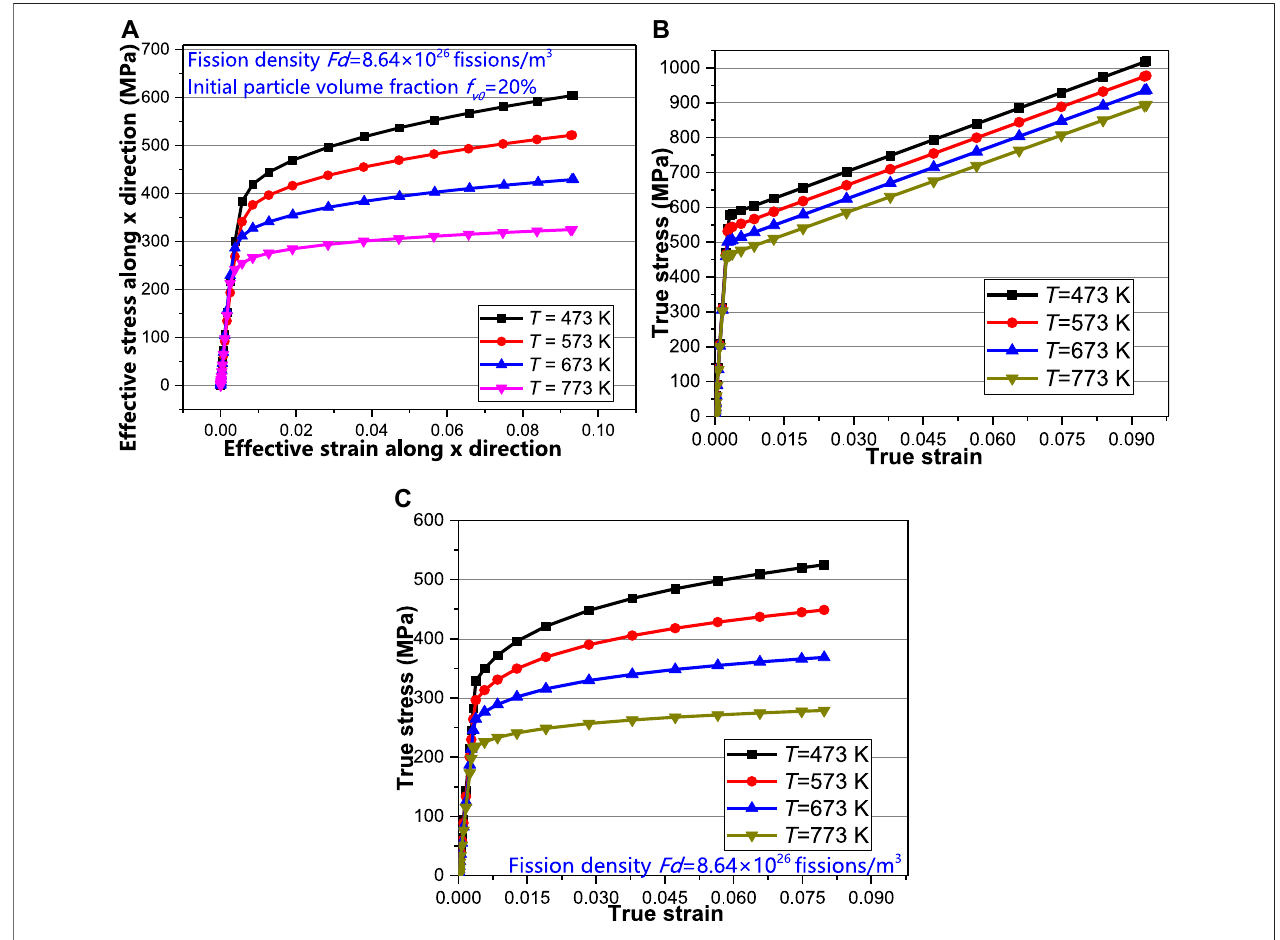
FIGURE14| Postirradiation (A) effectiveelastoplasticcurves, (B) stress – straincurvesofPuO 2 ,and (C) stress – straincurvesofthematrixmaterialunderdifferenttemperatures.